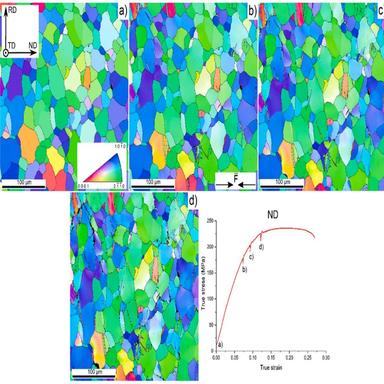
Microstructural evolution of the ND sample during compression represented by orientation maps corresponding to several points of interest on the deformation curve. Compression was applied in the horizontal direction.